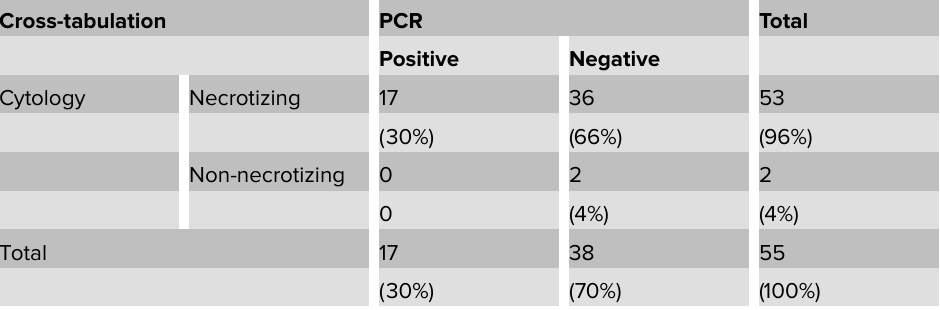
Table 1: Comparison of overall sensitivity of cytology and